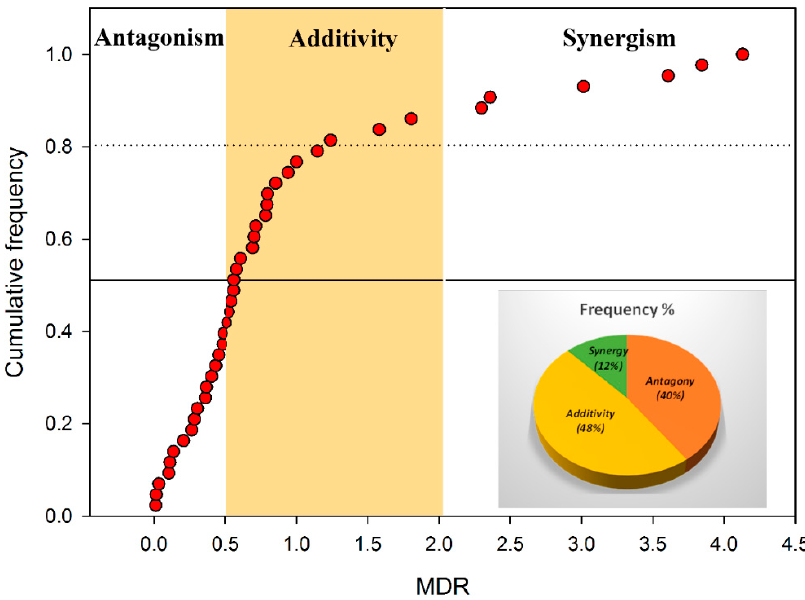
Figure 4. The cumulative distribution of model deviation ratios (MDRs) for quantifying the toxicity interactions of the binary mixtures of pharmaceuticals and pesticides ( n = 43 from Table 4, excluding combinations without MDR) for A. fischeri (synergism: MDR > 2; additivity: 0.5 ≤ MDR ≤ 2; and antagonism: MDR < 0.5).